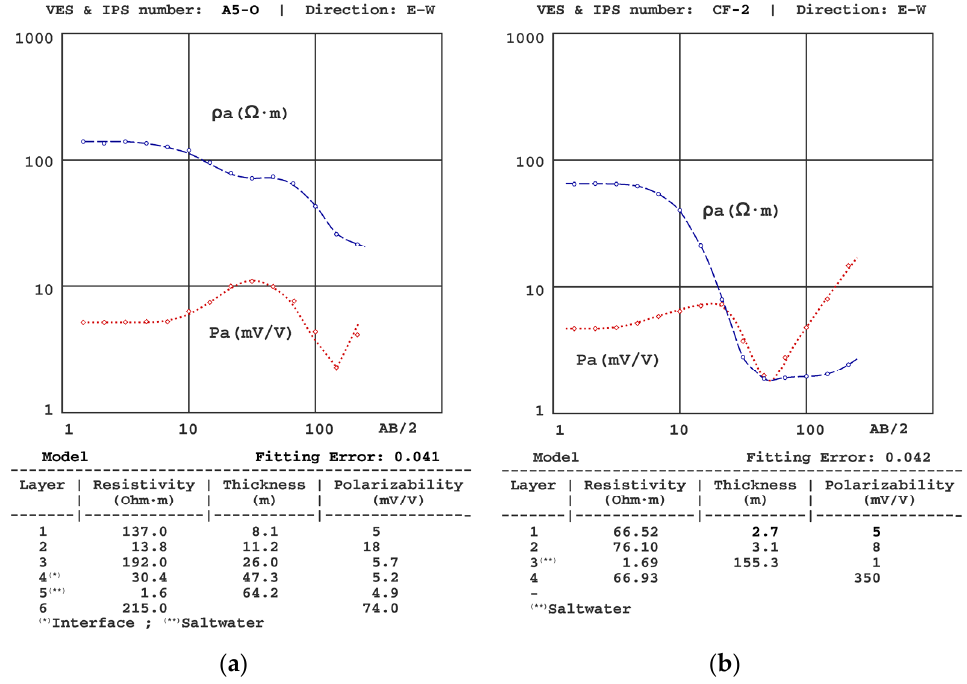
Figure 7. Results of the ( a ) A5-O VES-IPS obtained mid-autumn and ( b ) of the CF2 VES-IPS conducted in another basin in the same region.